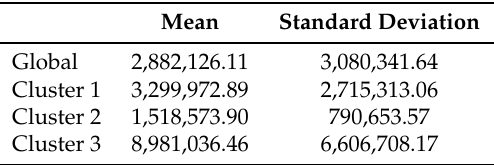
Table 4. ANOVA analysis of the flow passengers.